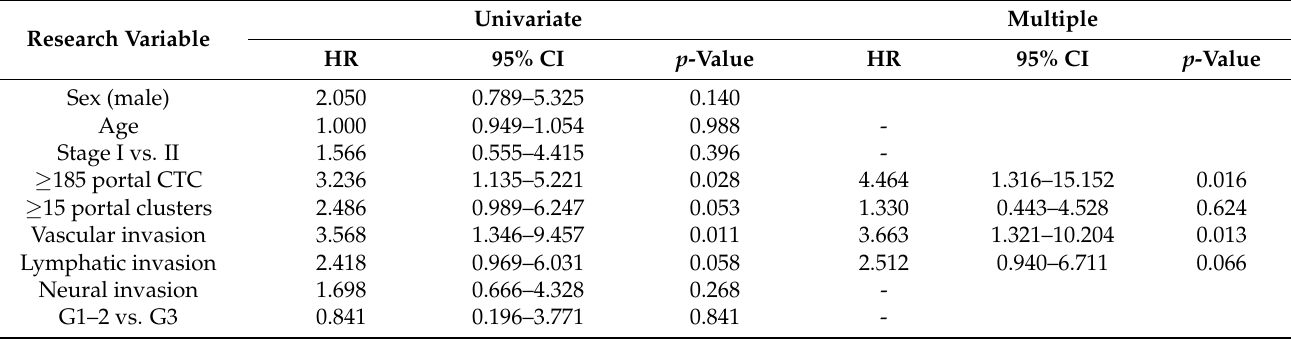
Figure 3. Overall survival according to ( a ) vascular invasion, HR = 3.568 (1.346–9.457); p = 0.011; ( b ) lymphatic invasion, HR = 2.418 (0.969–6.031); p = 0.058; ( c ) neural invasion, HR = 1.698 (0.666–4.328); p = 0.268; and ( d ) tumor grade differenti- ation, HR = 0.841 (0.196–3.771); p = 0.841. Blue line: no invasion or low grade (G1–2); red line: invasion or high grade (G3).